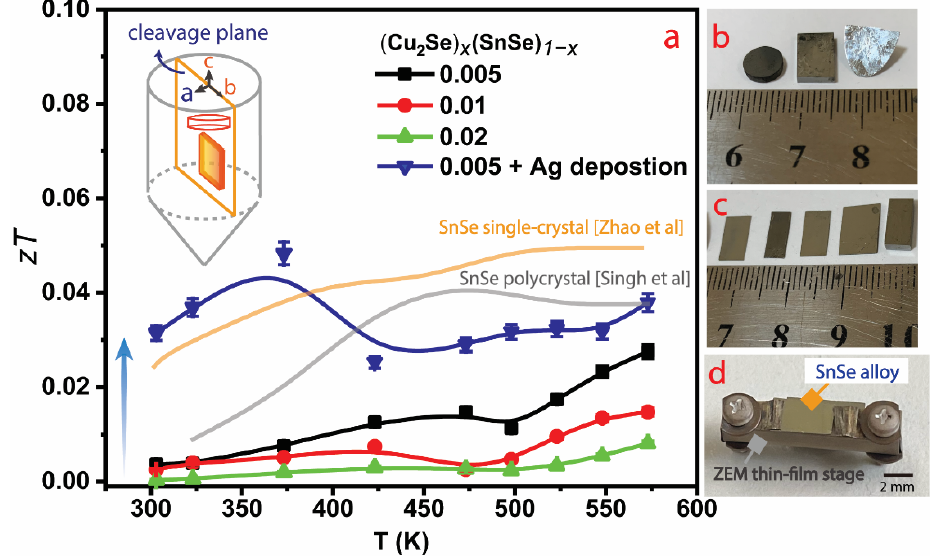
Figure 1. ( a ) Temperature-dependent zT profiles for (Cu 2 Se) x (SnSe) 1 − x ( x = 0.005, 0.01 and 0.02) and Ag-coating. The (Cu 2 Se) 0.005 (SnSe) 0.995 + Ag alloy is denoted as a solid curve, and reported SnSe single-crystal [4] and polycrystal [13] are added for comparison. Inset: Pictographic of TE properties measurement along the in-plane direction ( bc plane). ( b ) Left to right: Crystalline image for κ measurement (left, disk-shaped pellet), PF measurement (middle), cleavage plane from the as-grown bulk SnSe (right). ( c ) Plate-shaped SnSe alloys are sliced up to measure transport properties. ( d ) SnSe alloys were placed on a ZEM thin-film stage commercial apparatus for S and σ measurement.